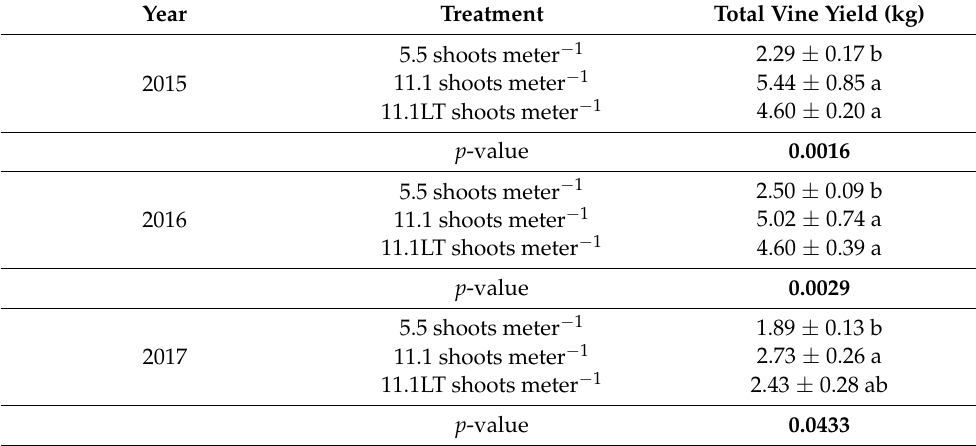
Table 8. One-way analysis of variance (ANOVA) showing average total vine yield (kg) by year and treatment at harvest during the 2015, 2016, and 2017 growing seasons ( n = 7). Table shows treatment means followed by the standard error of the mean. Different letters within a column indicate significant differences based on an Each pair, Student’s t -test. Significant p -values (<0.05) are displayed in